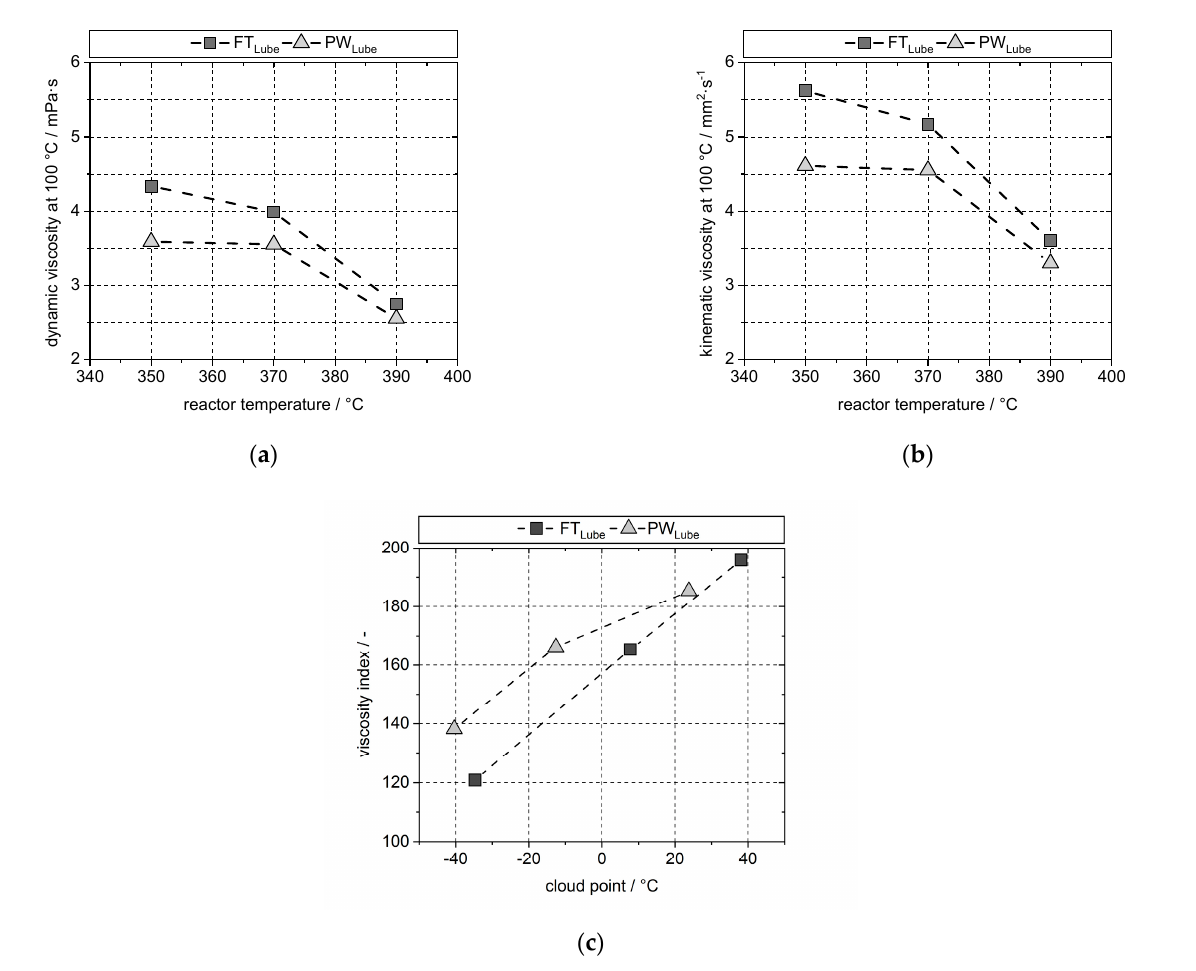
Figure 11. Dynamic ( a ) and kinematic ( b ) viscosity for lubricants/waxes at different reactor temperatures and viscosity index values of FT and PW lubricants plotted against their individual cloud points ( c ).